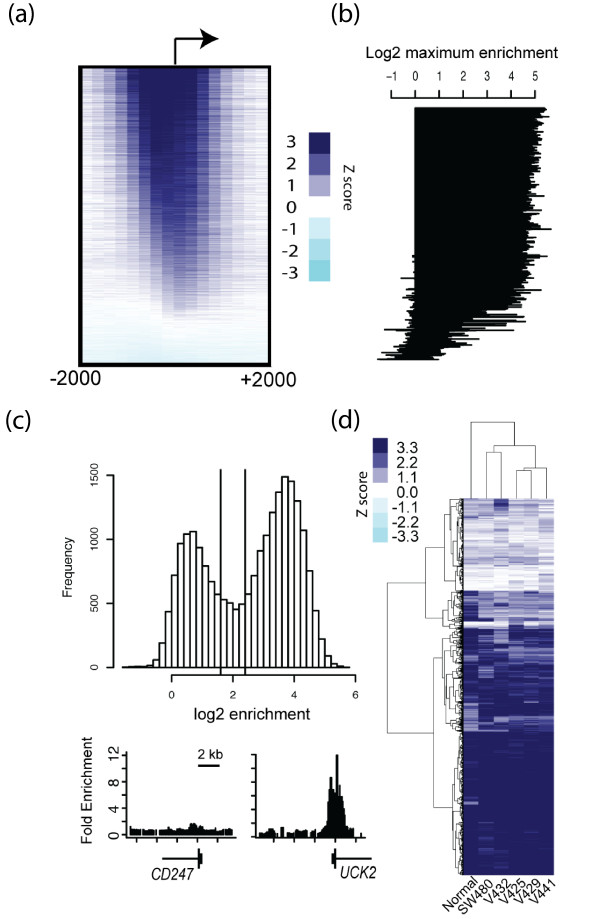
ChIP-chip of H3K4me3. (a) Enrichment of H3K4me3 within 2 kb of all human TSSs. (b) Maximum enrichment of H3K4me3 within 1 Kb of the TSS for each human gene. Genes are ordered similarly to (a). (c) Histogram of H3K4me3 signals at all human TSSs. The vertical lines correspond to thresholds used to distinguish genes containing high levels of H3K4me3 (right-side of the distribution) from genes containing low H3K4me3 levels (left side of the distribution). Genes falling between the two vertical lines are indeterminate and not designated as K4-absent or K4-present genes. The bottom panel shows an example of a gene lacking H3K4me3 (CD247), and a gene containing H3K4me3 (UCK2). (d) Maximum H3K4me3 signal at all TSSs in the five colorectal cell lines (SW480, V432, V425, V429, V441) and normal colon mucosa. Columns represent individual samples, and rows represent H3K4me3 signals at TSSs. Dark blue corresponds to high H3K4me3 enrichment; light blue corresponds to little or no enrichment.